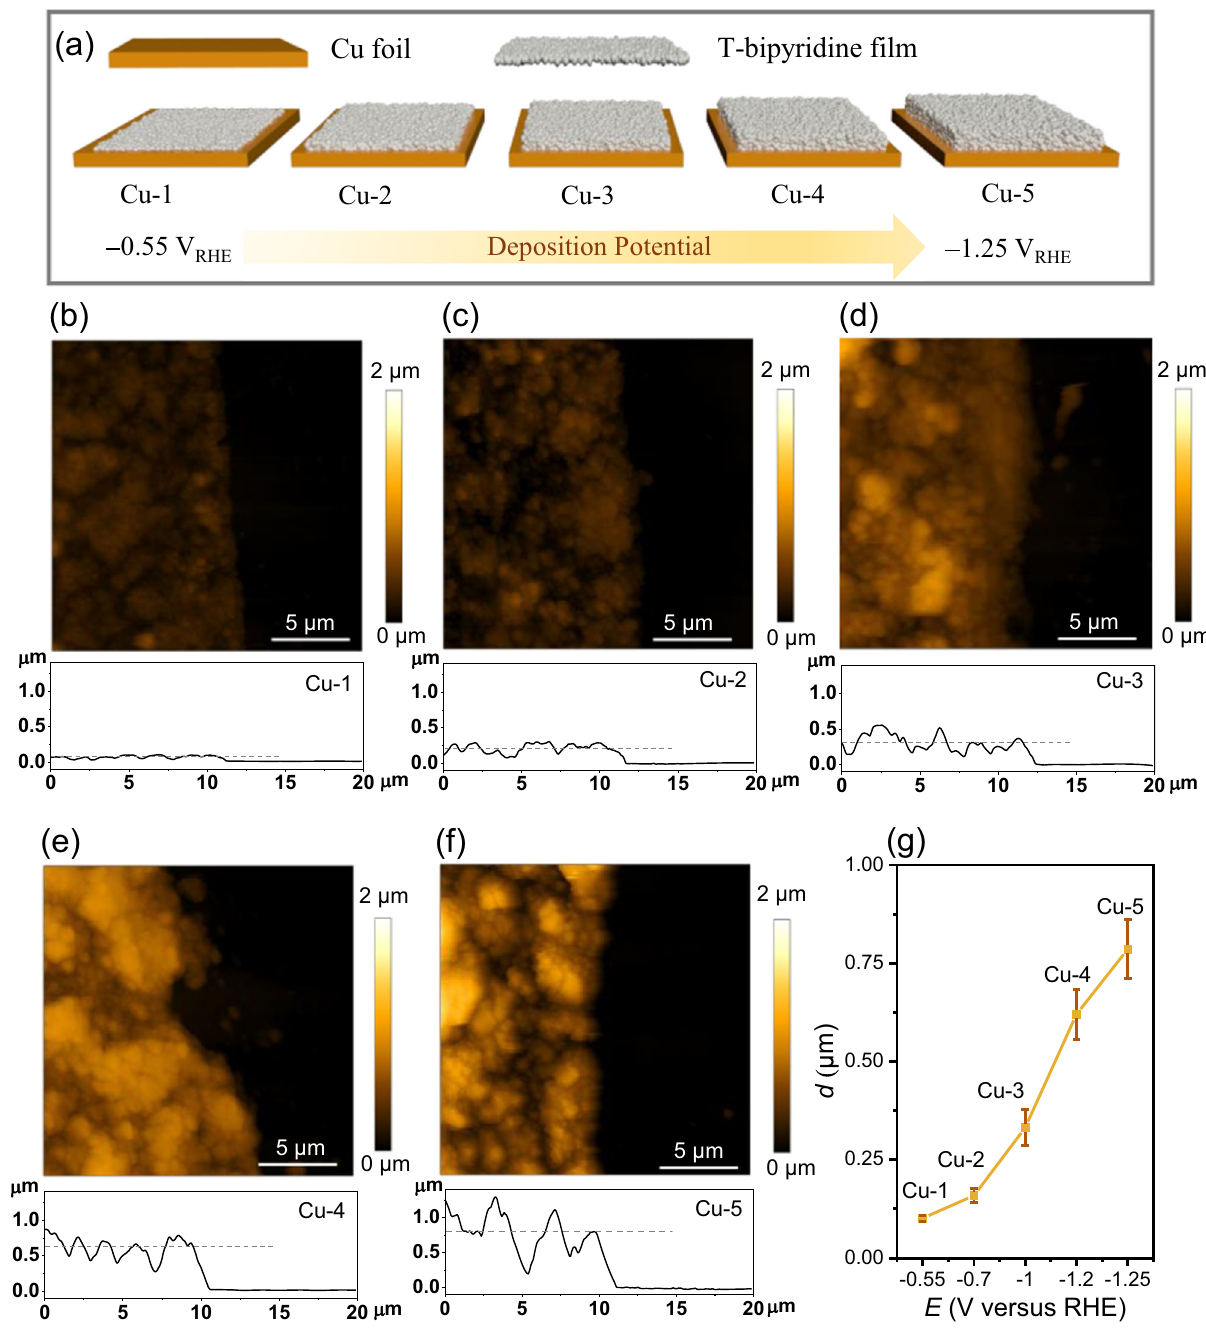
Fig. 1 | Thickness characterization of of T-bipyridine modi fi ed Cu electrodes. a Schematic of the fi ve T-bipyridine modi fi ed electrodes denoted Cu-n (n=1 − 5). b − f AFM images and cross-sectional pro fi les of the edge plane (20×20 μ m 2 ) on